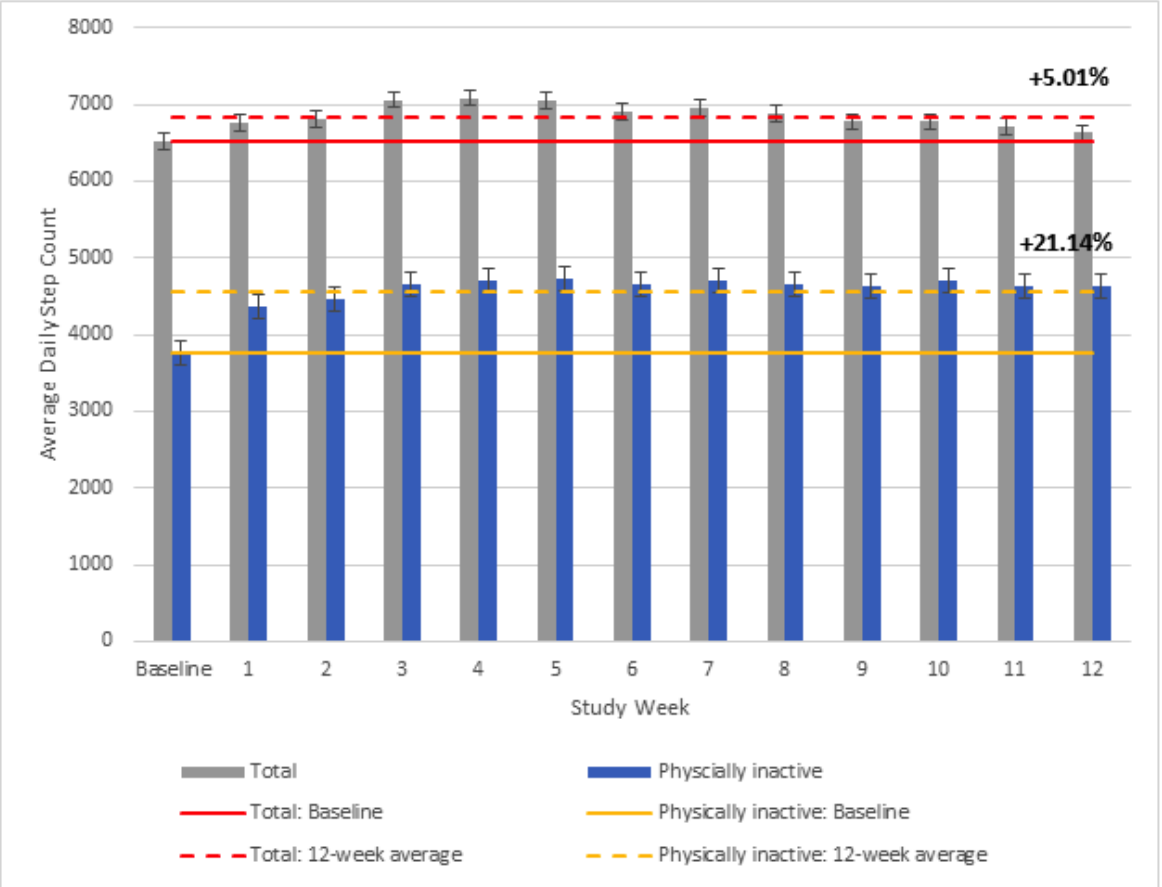
Figure 2. Least-square means for daily steps at baseline and for each study week during the 12-week evaluation period for the total sample and physically inactive